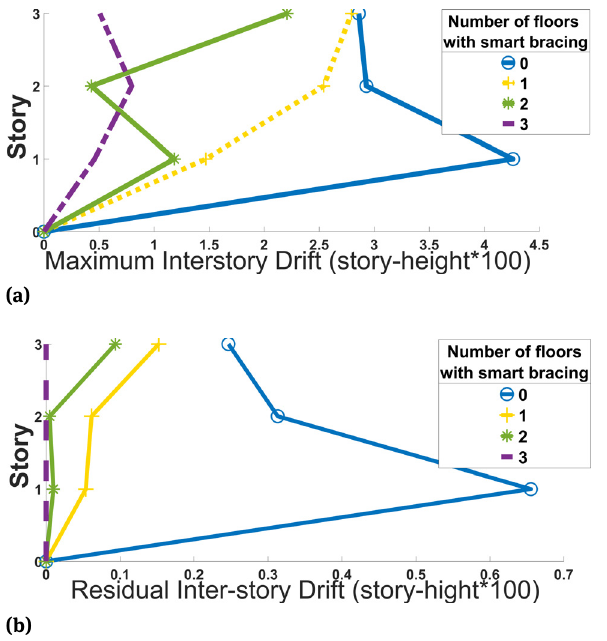
Figure 8: Maximum interstory drift regarding the number of floors equipped with SMA braces along the height; (b) Maximum residual interstory drift regarding the number of floors equipped with SMA braces along the height.